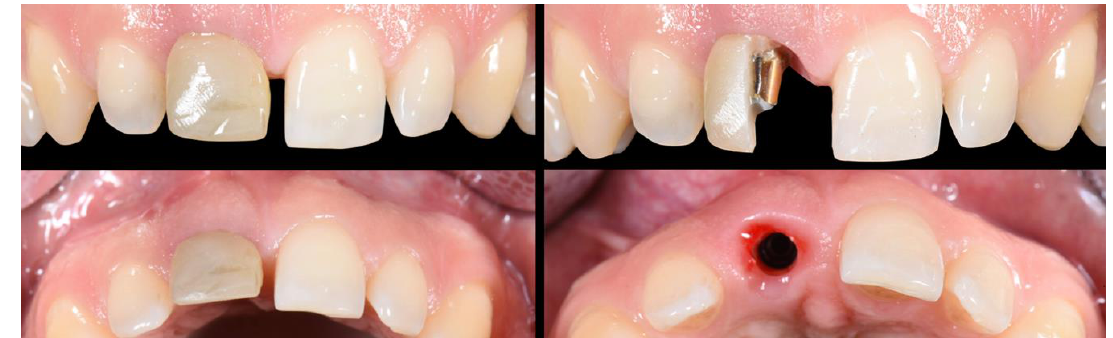
Figure 13. Three months post-op re-evaluation. Soft tissue conditions at time of removal of the first provisional restoration.